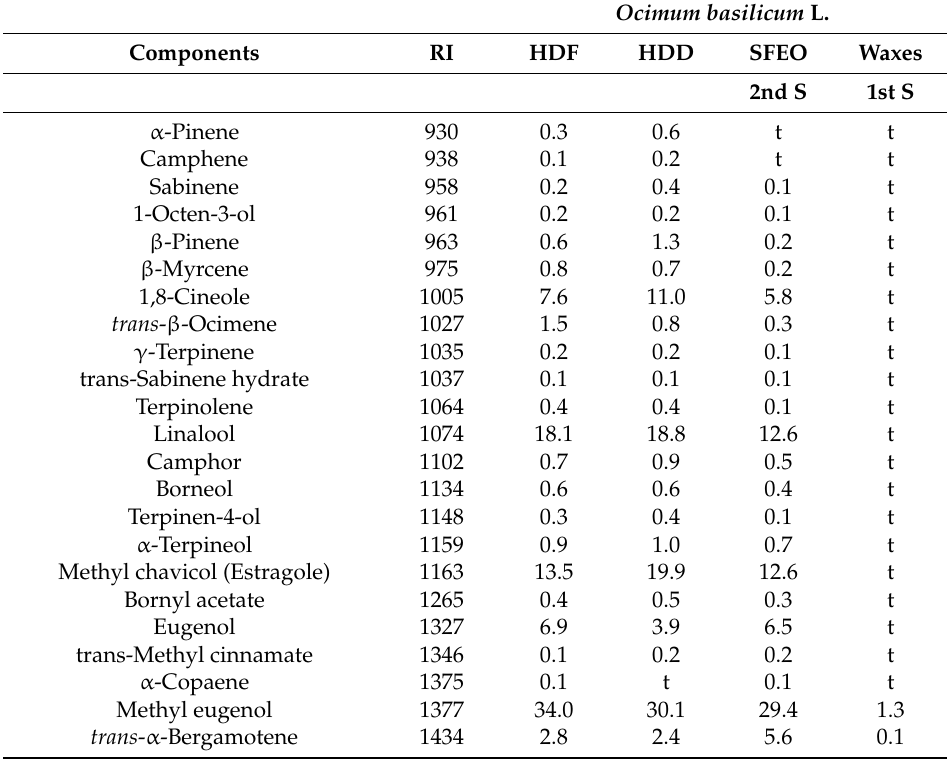
Table 2. Percentages of compounds from the essential oil samples of fresh (HDF) and dried (HDD) basil, SFE volatile oil (SFEO), and